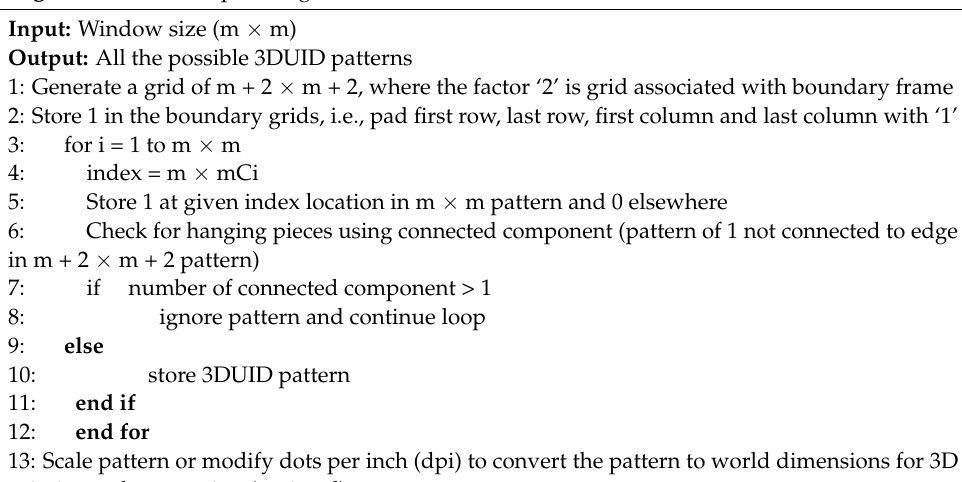
Algorithm 1. 3DUID pattern